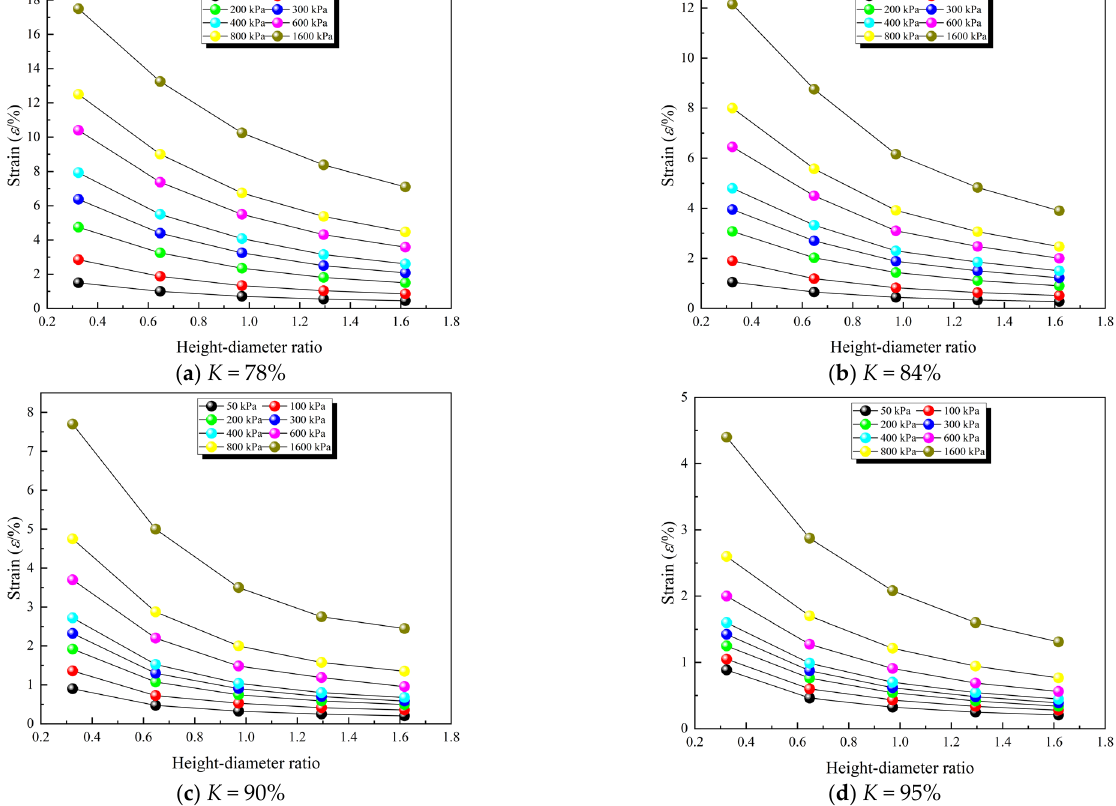
Figure 5. The relationship between strain and H/D ratios under different compaction degrees.